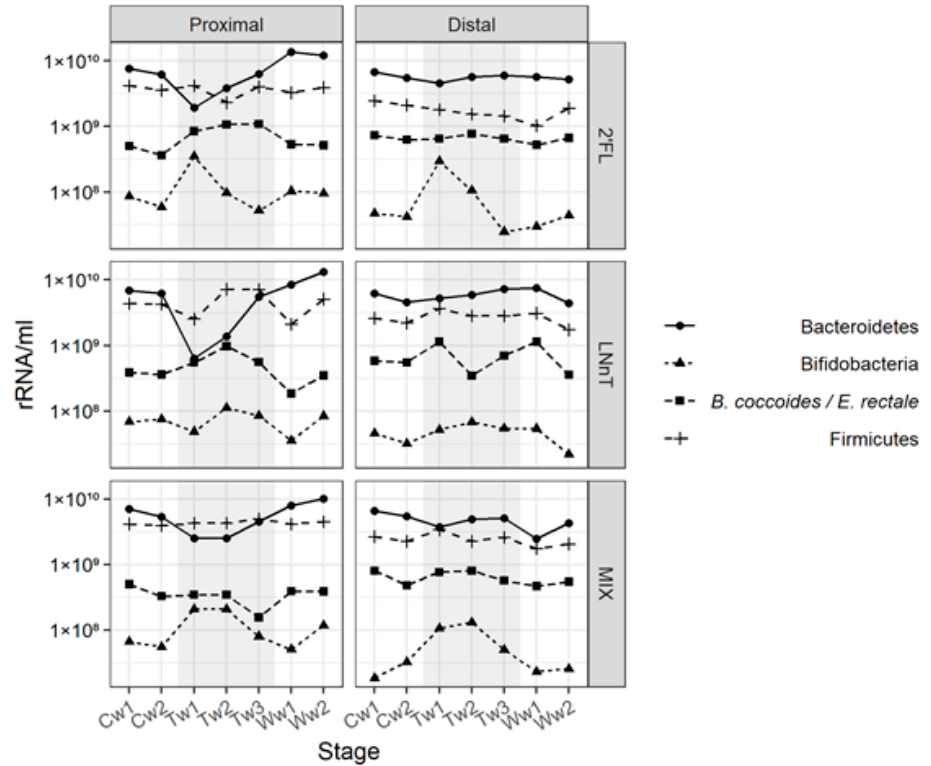
Figure 2. ImpactofHMOs, 2’FL( toppanel ), LNnT( middlepanel ), andMIX( bottompanel ), onmicrobial populations in the SHIME ® model. The relative proportion of Bifidobacterium, B. coccoides / E. rectale , Firmicutes and Bacteroidetes in the lumen of the proximal and distal colon vessel was determined by qPCR. Samples for qPCR analysis were collected once a week during two weeks of control period (Cw1 and Cw2), three weeks of treatment period (Tw1, Tw2 and Tw3), and two weeks of washout period (Ww1 and